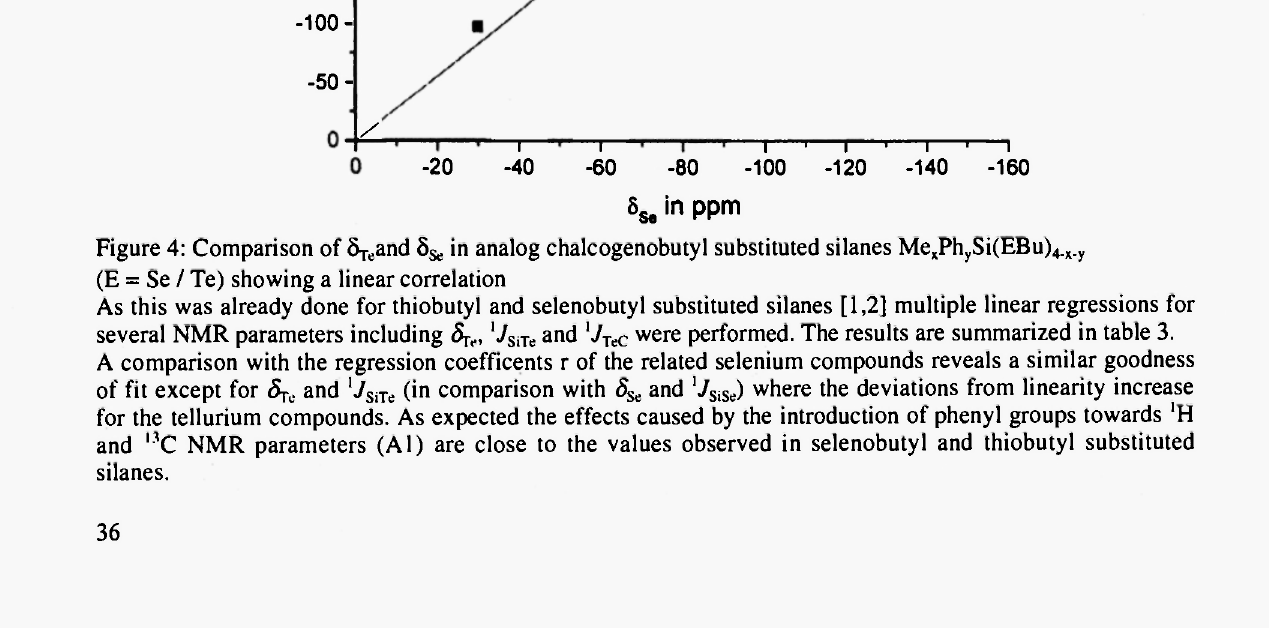
Figure 3: Comparison of 'J SjTe and 'J SiSe in analog chalcogenobutyl substituted silanes Me x Ph y Si(EBu) 4 . x . (E = Se / Te) showing a linear correlation